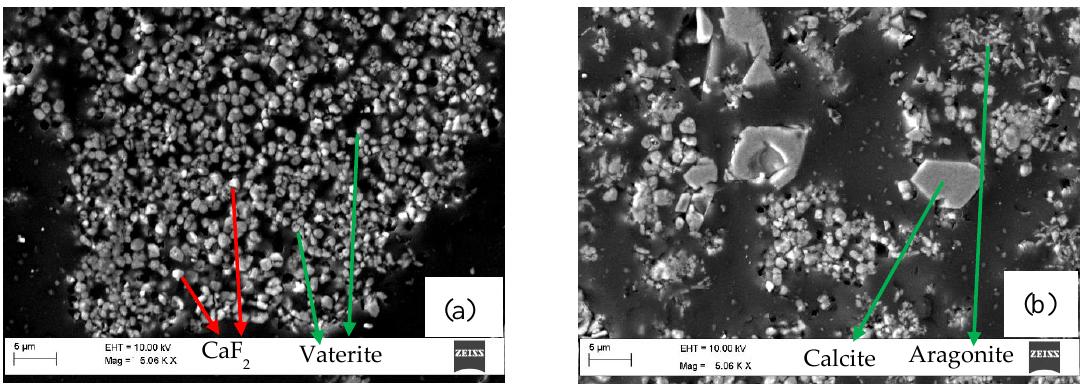
Figure 4. SEM image of residue obtained from the experiment with Na 2 CO 3 at 95 ◦ C and pH 10.6. ( a , b ) show two di ff erent regions of the same sample.